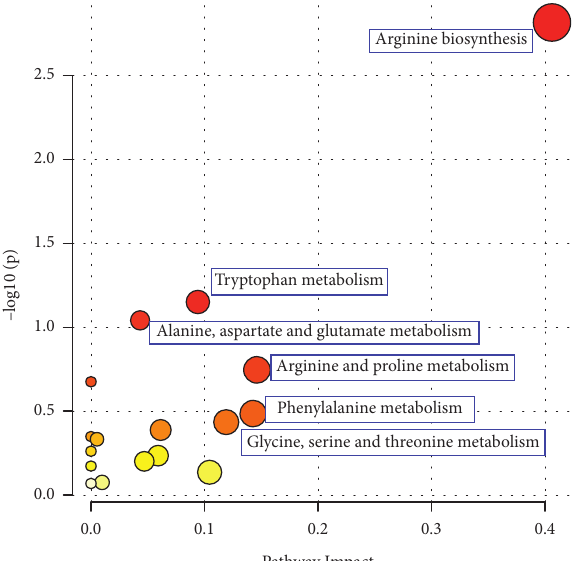
Figure 2: Pathway analysis for hypertensive children vs. normotensive children in the (a) positive mode and (b) negative mode.